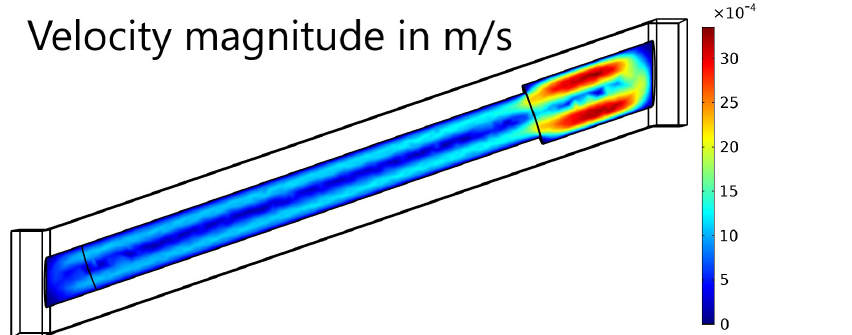
Figure 8. Velocity magnitude within the light-conducting element (LCE) in state 2 for the highest ∆ T IC OC from Table −